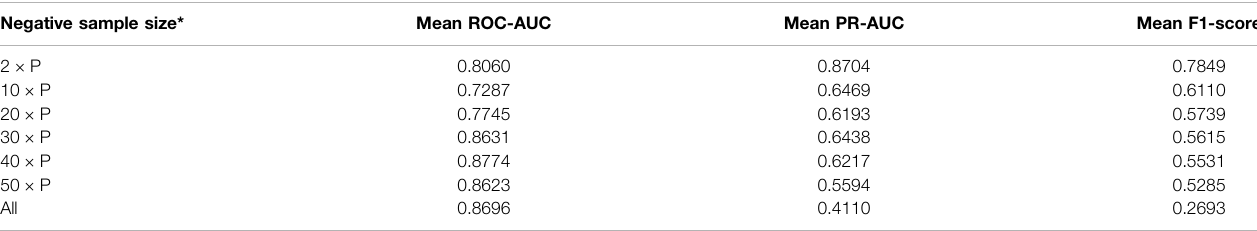
TABLE 1 | Average ROC-AUC, PR-AUC, and F1-score as the size of negative samples increases. Negative sample size*